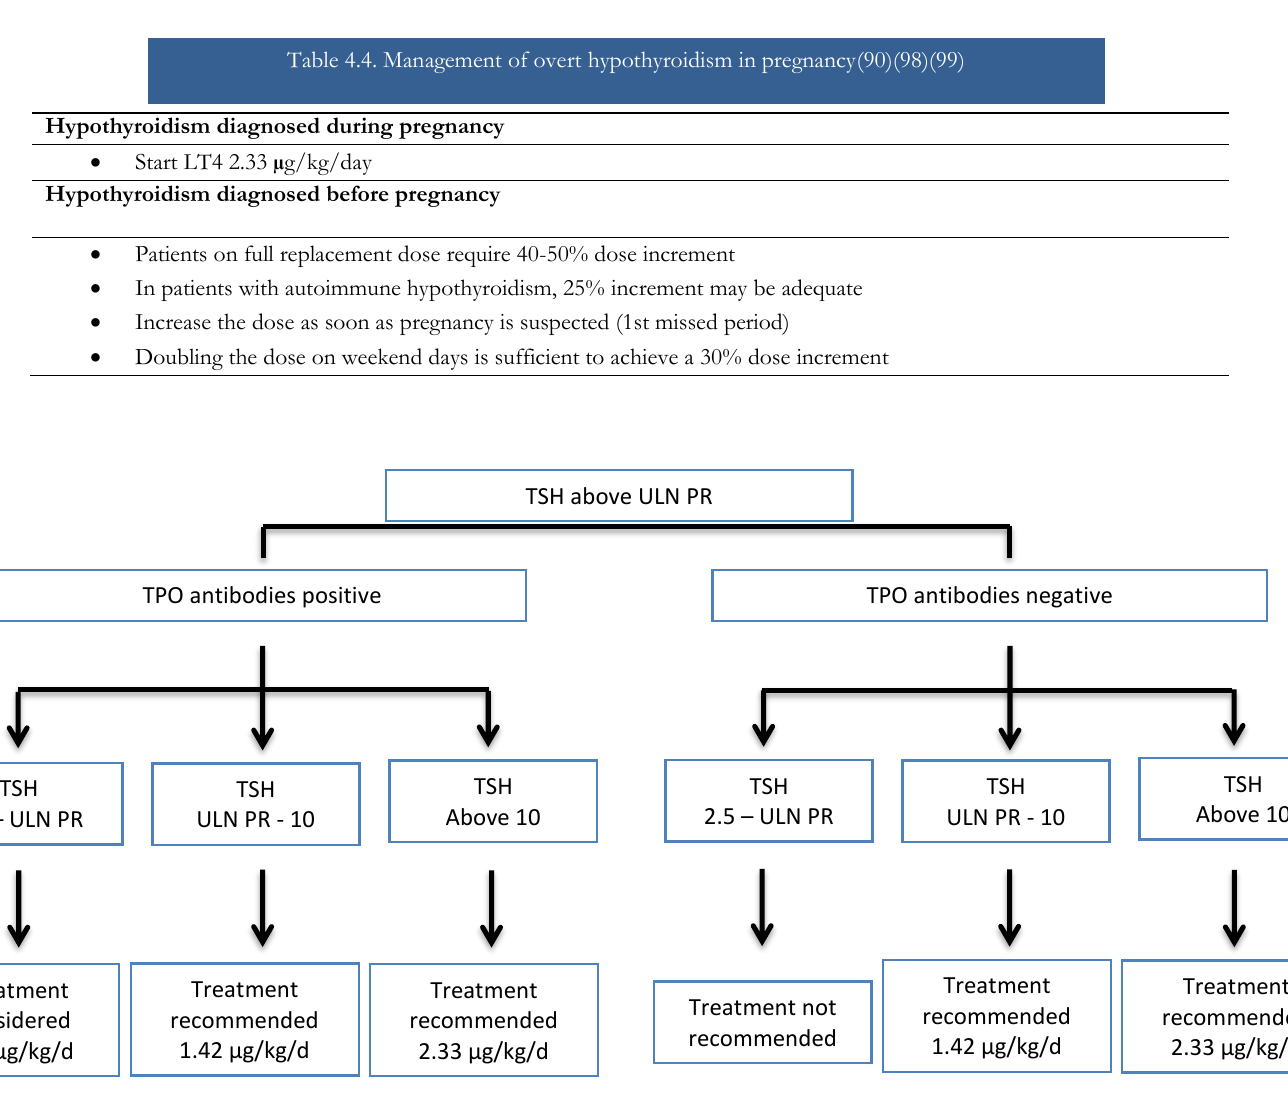
Figure 4.2. Treatment algorithm for subclinical hypothyroidism in pregnancy (90)(98)(95)